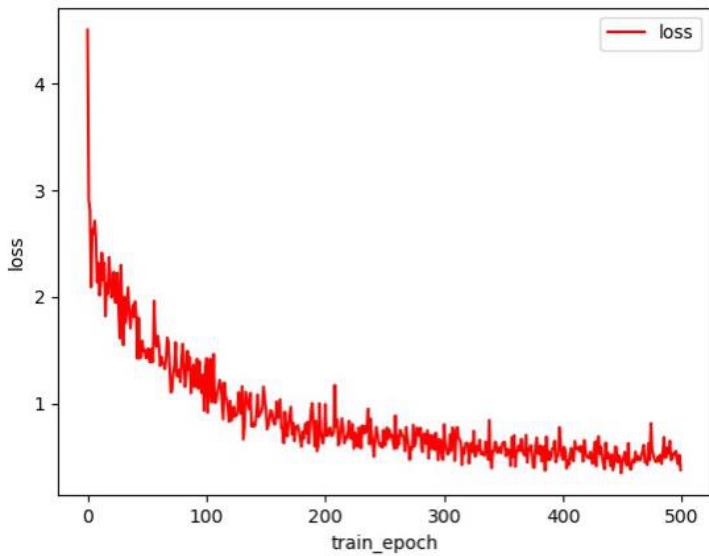
Figure 11. BP neural network training process. Table 4. Training factor test results for the three combinations.